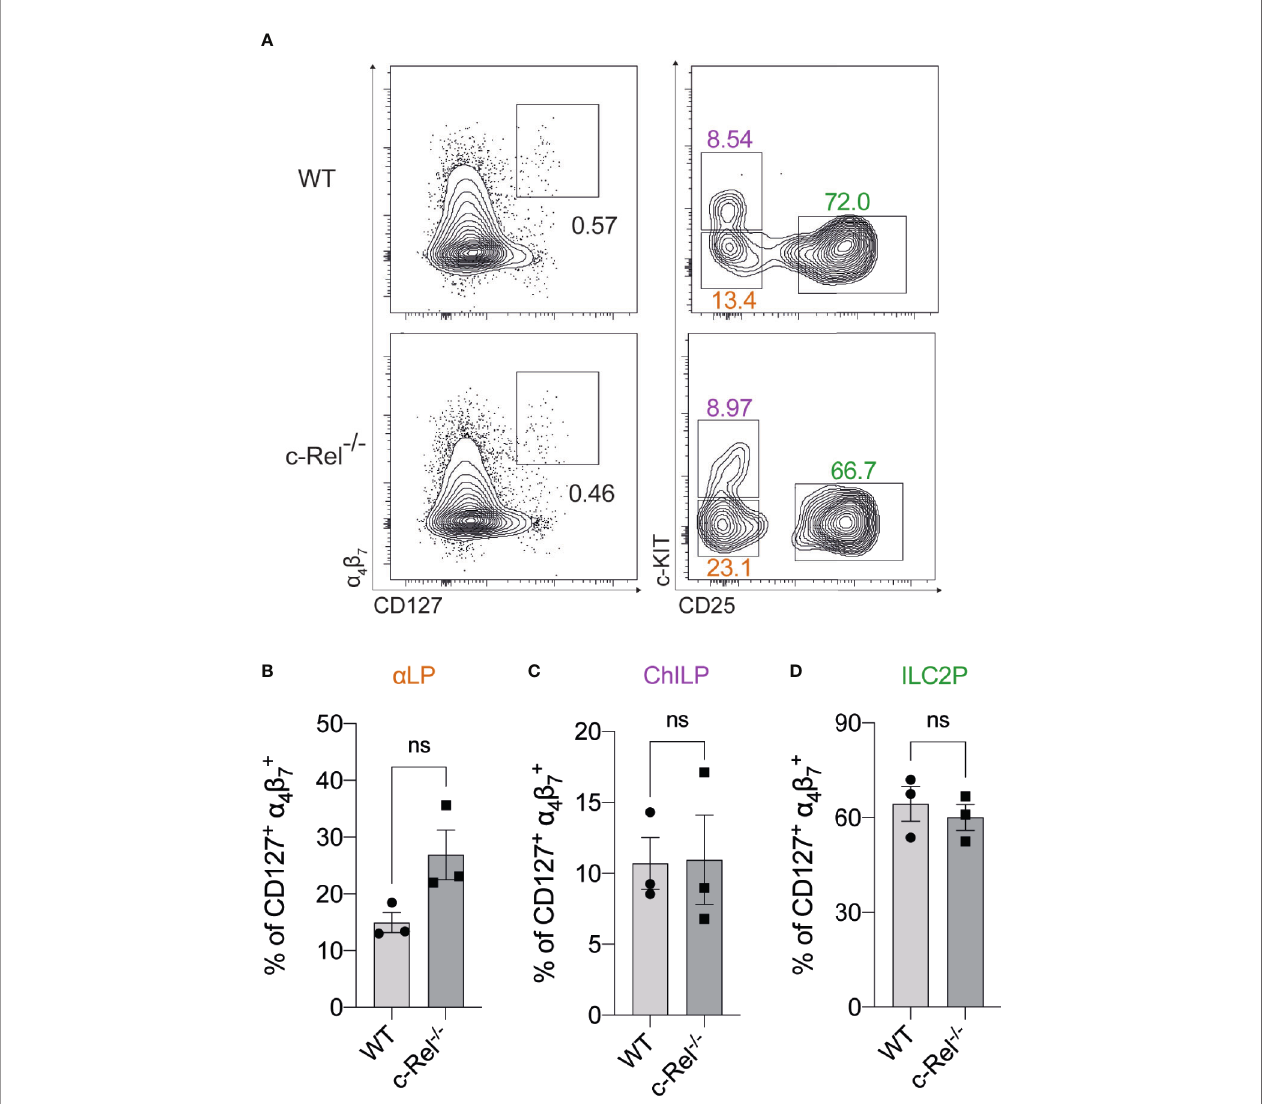
FIGURE 2 | The development of BM-derived immature ILC2s are independent of c-Rel (A) Representative fl ow cytometry plot of a 4 b 7 + CD127 + immature BM ILC2s (left) (gated on viable CD45 + Lin - cells) and speci fi c ILC2 progenitors (gated on parent a 4 b 7+ CD127 + cells). a -lymphoid progenitors ( a LPs) were de fi ned as c-KIT low CD25 - , whereas common helper innate lymphoid progenitors (ChILPs) and ILC2 precursors (ILC2Ps) were c-KIT high CD25 - and c-KIT low CD25 + , respectively. (B – D) Quanti fi cation of a LP, ChILP and ILC2P among a 4 b 7+ CD127 + cells, respectively. All plots and graphs are representative of at least two independent experiments with at least three mice per group. Error bars represent ± SEM. ns, non-signi fi